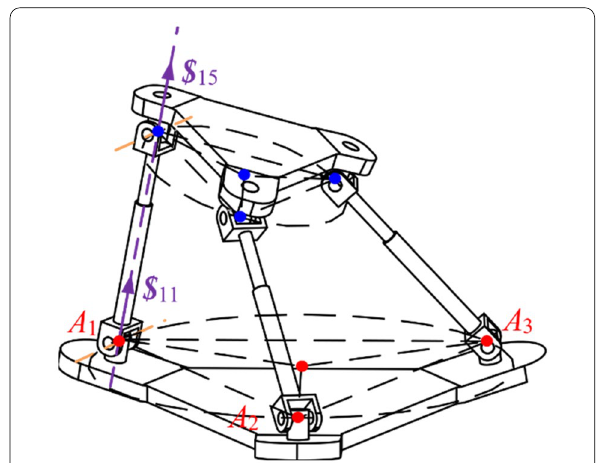
Figure 9 Limb singularity